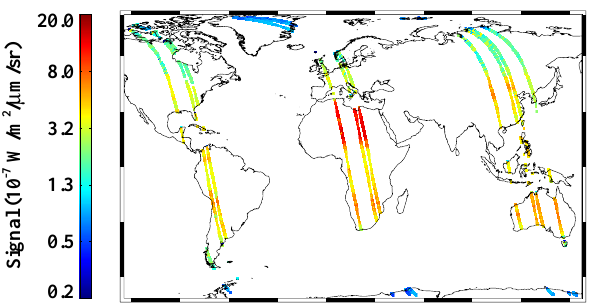
Fig. 4. Distribution of soundings used in the simulation-based tests; the plotted variable is the band 2 signal level. There are ten or- bits containing a total of 6522 soundings, spanning 14–16 Septem- ber